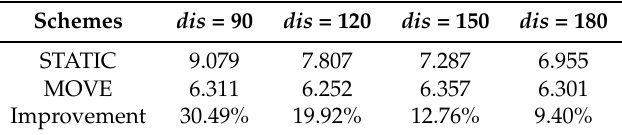
Table 2. Average tracking errors for MOVE and STATIC with different adjacent node distance dis L .